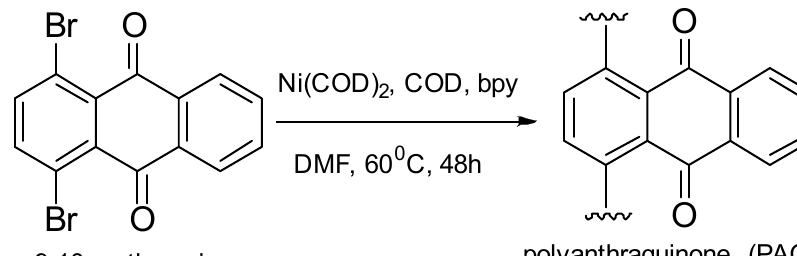
Figure 2. Direct polymerization of low voltage polymer.